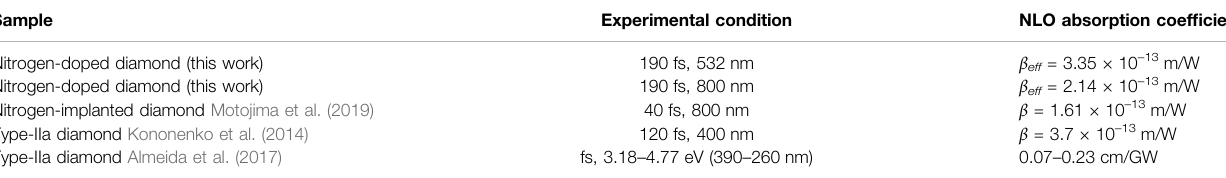
TABLE 1 | NLO absorption coef fi cients of diamonds under different experimental conditions from open-aperture Z-scan measurements.